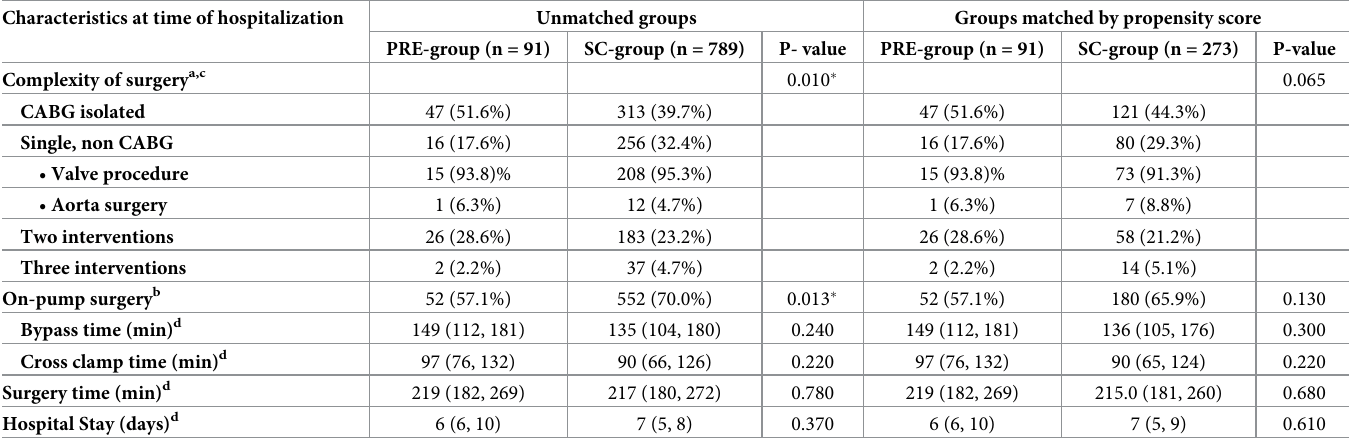
Table 3. Operative and postoperative